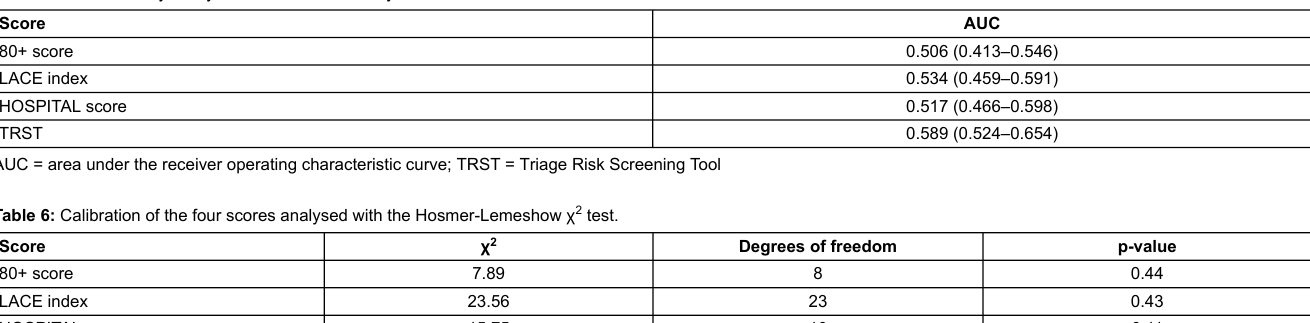
Table 5: Discriminatory ability of the four scores analysed with c-statistics.